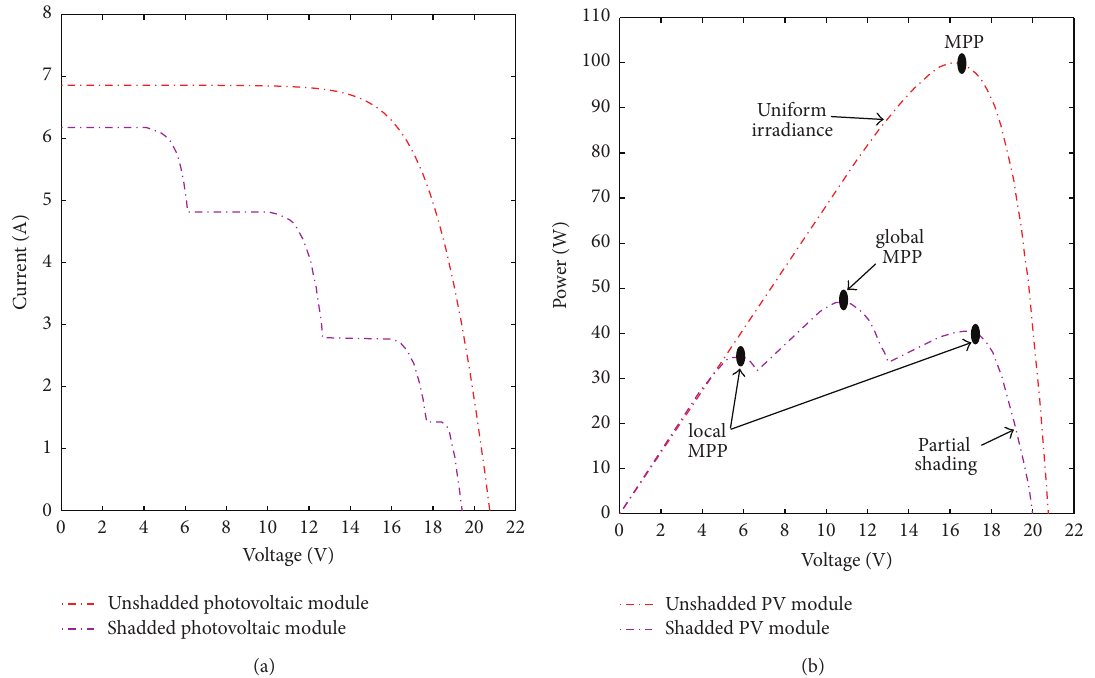
Figure 5: (a) shows I-V characteristic of PV system under shading and nonshading condition and (b) shows the P-V characteristic of PV system under shading and nonshading condition, respectively.